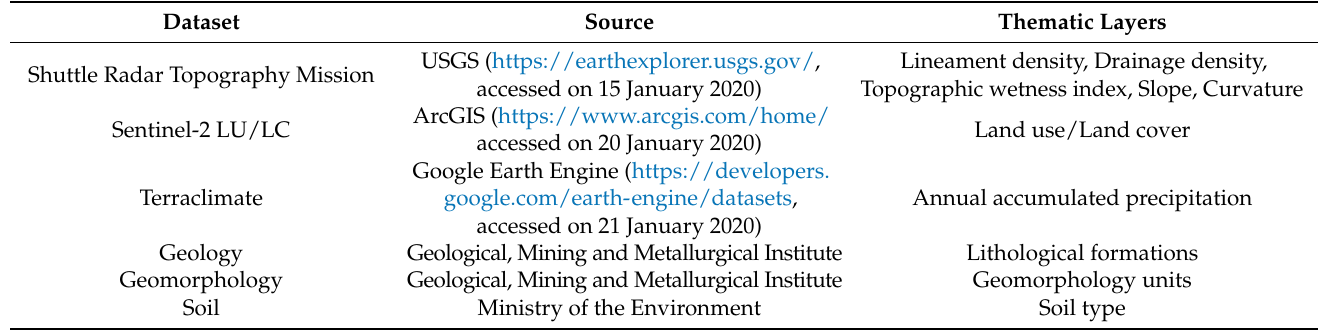
Figure 2. Flowchart of the methodology used for GWPZ mapping. Table 1. Datasets used and their associated thematic